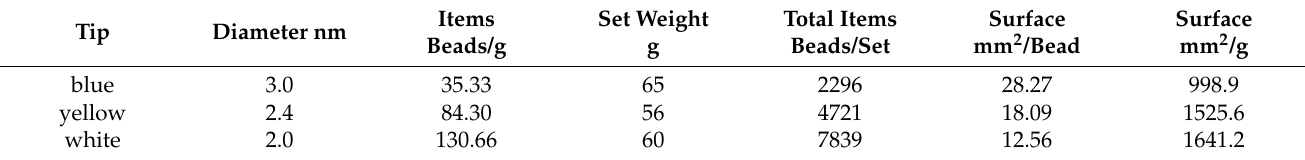
Table 1. Alginate beads prospects to immobilize P. koreensis .